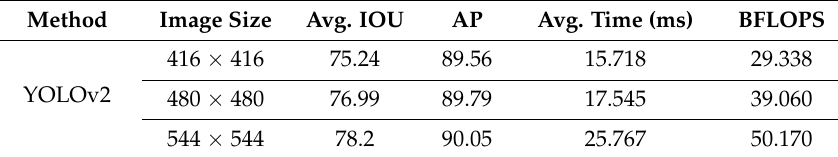
Table 6. Evaluate the Performance of YOLOv2 with Different Image